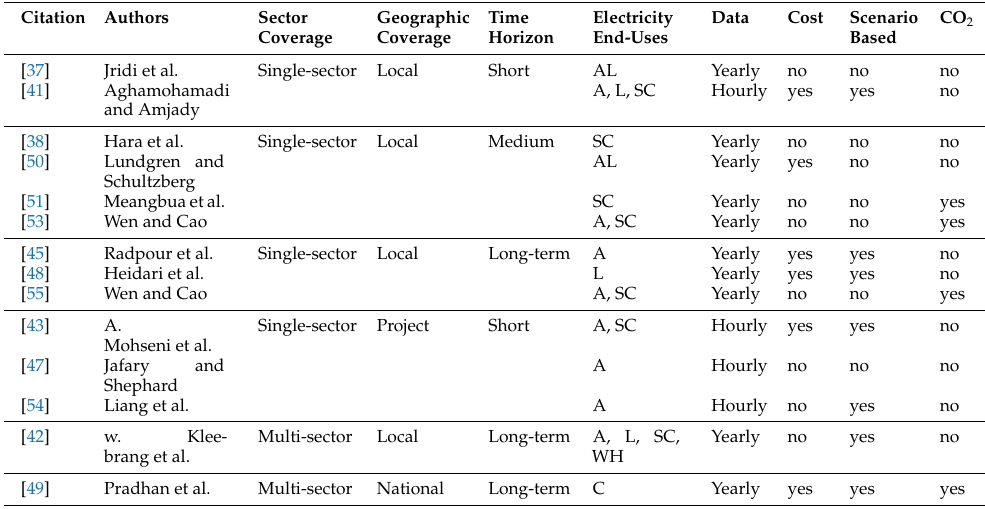
Table 8. Characteristics of bottom-up energy models-Residential